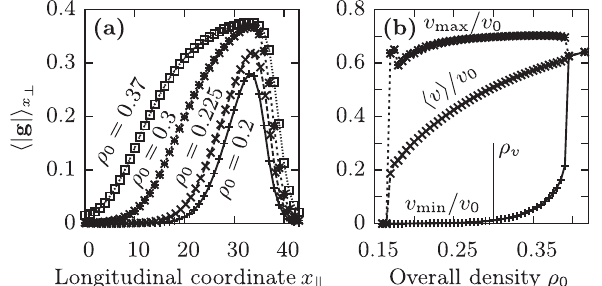
FIG. 11. Cluster-lane geometry in periodic systems. (a) Schematic of the position of a cluster lane ’ s midline for winding number w ¼ 2 and length parameter l ¼ 3 . (b) Illustration of a cluster-lane pattern with orientation α ¼ α 1 linear extent L ¼ 125 . Cluster lanes are indicated by dashed white lines, cluster lanes ’ midlines indicated by thin solid lines. The direction of motion is indicated by arrows. (c) Asymmetric cluster-lane pattern observed in a system of linear extent L ¼ 150 . The parameters for (b) and (c) are σ ¼ σ 0 ¼ 0 . 5 and ρ ¼ 0 .